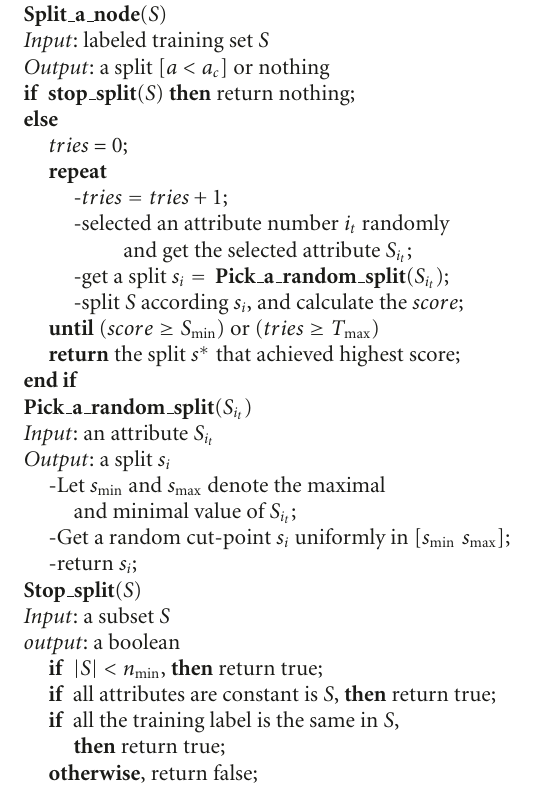
Algorithm 2: Tree growing algorithm of